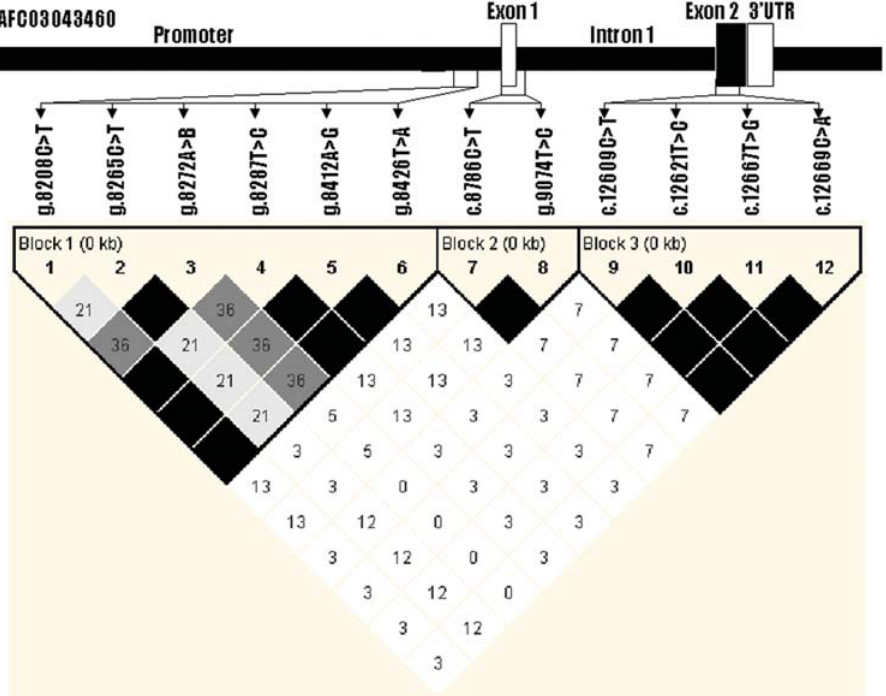
Figure 1. Genomic organization and haplotype analysis in the bovine UCN3 gene. Noncoding exon 1, partial non-conding exon 2 and 3 9 untranslated region are marked by white boxes and coding exon 2 by a black box. Pairwise linkage disequilibrium relationship for 12 mutations is illustrated based